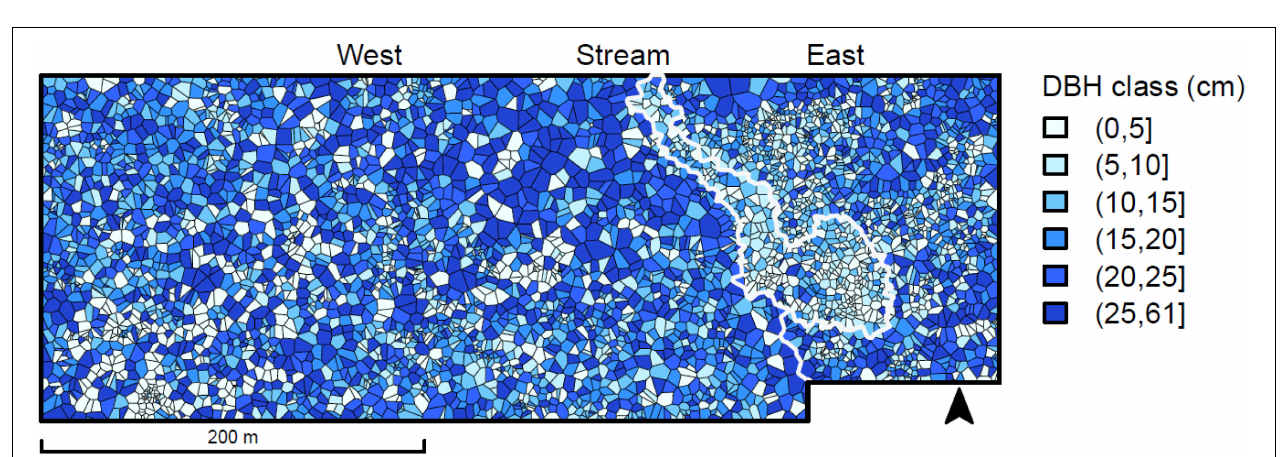
FIGURE 4 | Voronoi tessellation for the living trees in the study area, colored by tree diameter class. The eastern side of the plot includes a stream area and its paludified surroundings, both with a high density of small trees.